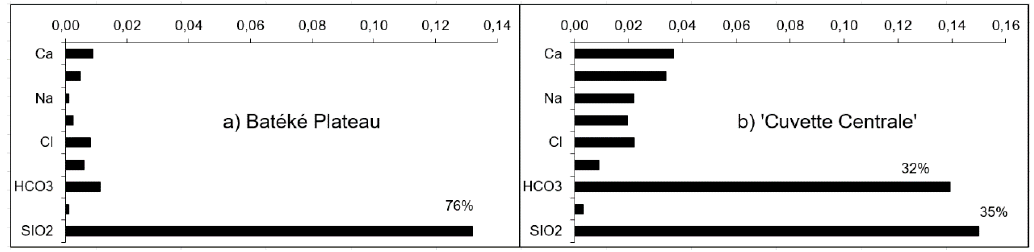
Figure 19. Composition of dissolved mineral phases (issue from mean concentration in mmol.l − 1 , of ( a ) Batéké Plateau rivers versus ( b ) “Cuvette Centrale” rivers (adapted from Laraque et al., 1998) [10]. For the Batéké rivers, the interannual runoff coefficient (ratio between the runoff and the rainfall) ranges between 45–60%, versus 20–30% for the “Cuvette Centrale”. The average seasonal variability of discharges (mean ratio between the highest and lowest monthly discharge for each studied year) ranges between 1.1 and 1.5 for the Batéké rivers, versus 2.5 and 5.5 for the “Cuvette Centrale” rivers.